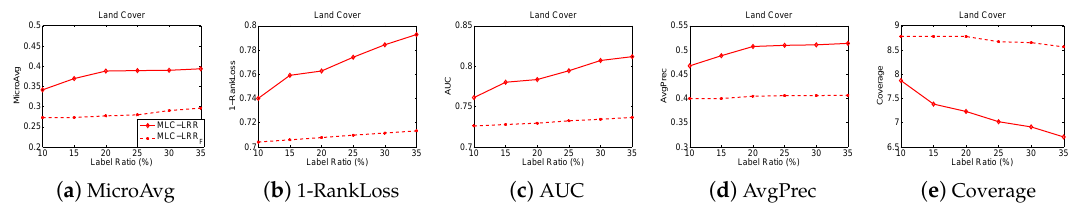
Figure 4. MLC-LRR vs. MLC-LRR F on the Land Cover dataset under different label ratios across five evaluation metrics ( a–e ).